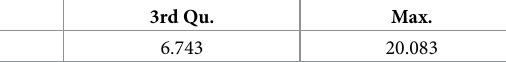
Table 4. The summary measures of the first COVID-19 data.